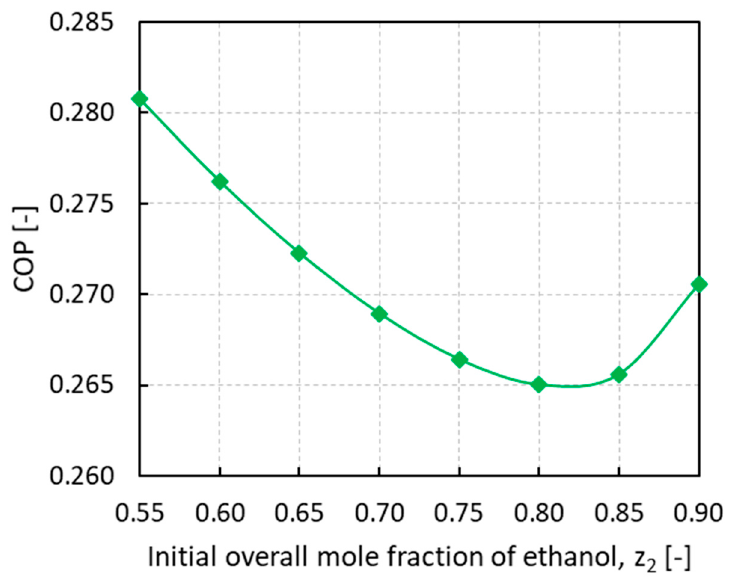
Figure 7. Coefficient of performance (COP) of thermodynamic adsorption cycle vs. the initial overall mole fraction of ethanol z 2.